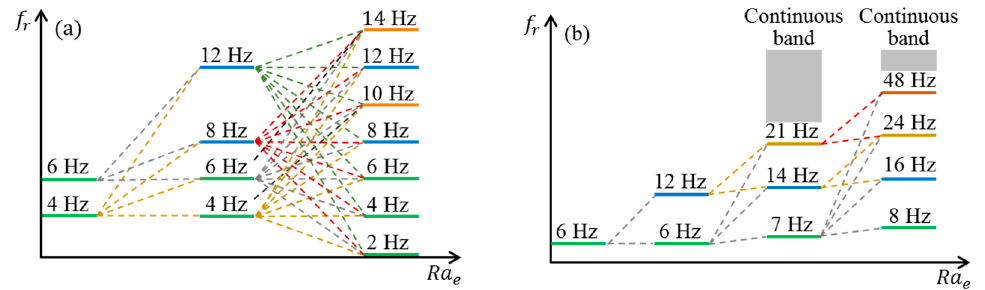
Figure 14. Schematic of f r vs. Ra e , where Q = 3 µ L/min and the conductivity ratio of the streams is 1:5250. ( a ) f f = 4 Hz, ( b ) f f = 130 kHz.